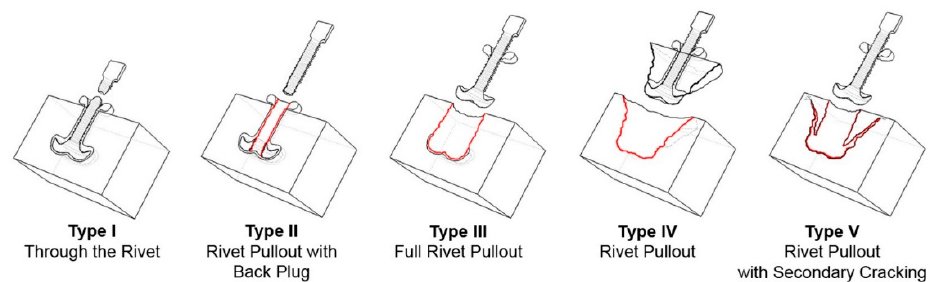
Figure 7. Current failure modes of friction riveted joints reported in the literature (Reprinted from J. Mater. Process Technol. [10]).